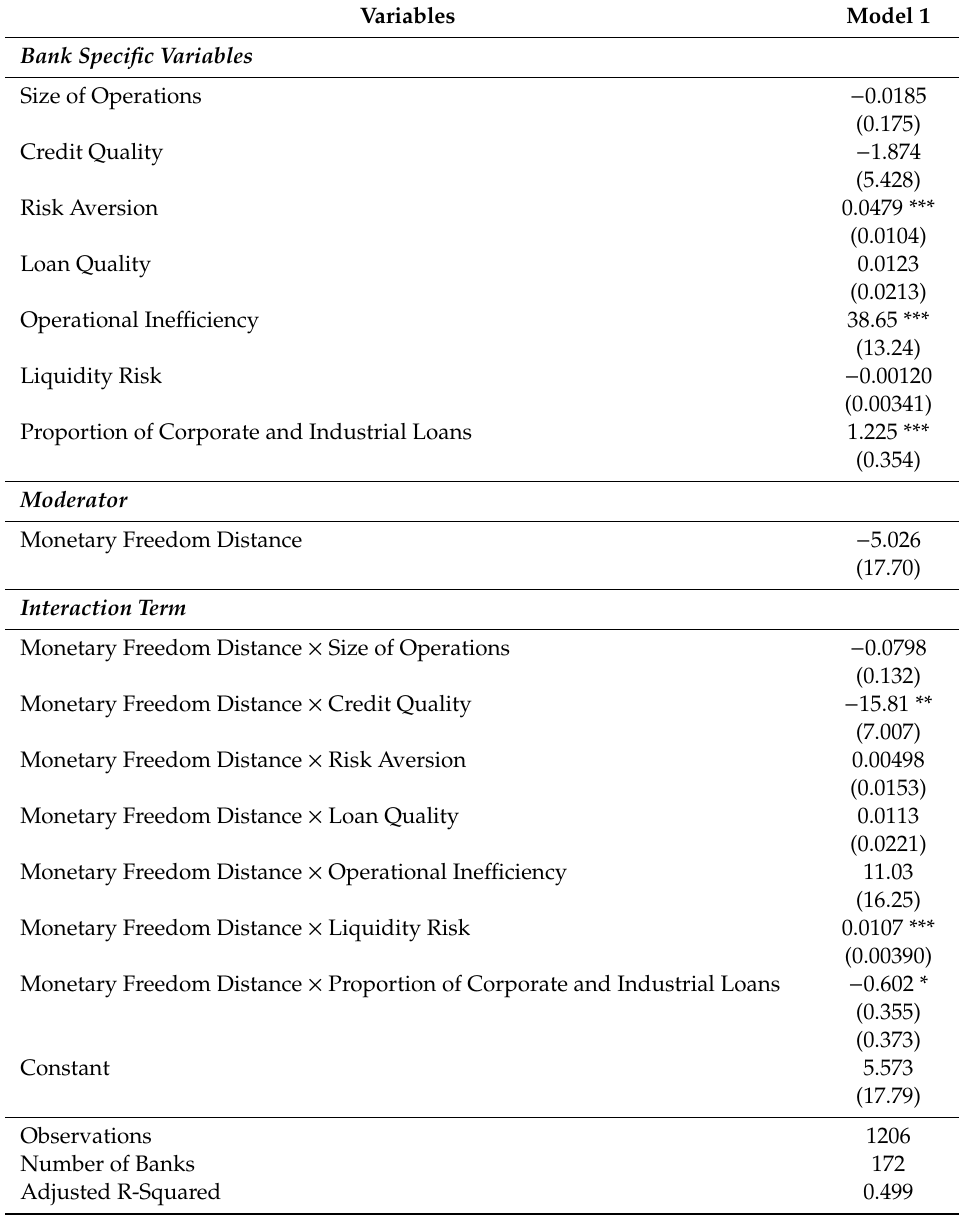
Table 7. The moderating e ff ect of monetary freedom and the impact of